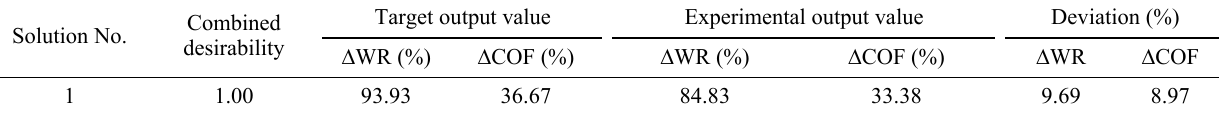
Table 8 Variation between experimental and target values based on predicted test condition of desirability value